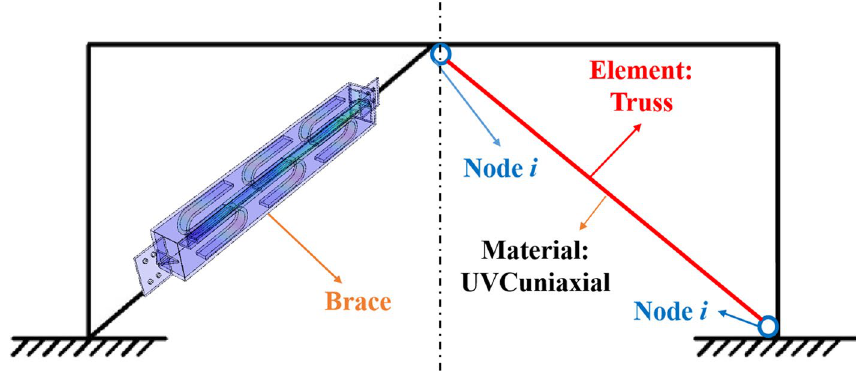
Fig. 19 Simulation for brace based on ABAQUS (left part) and OpenSEES (right part) platforms